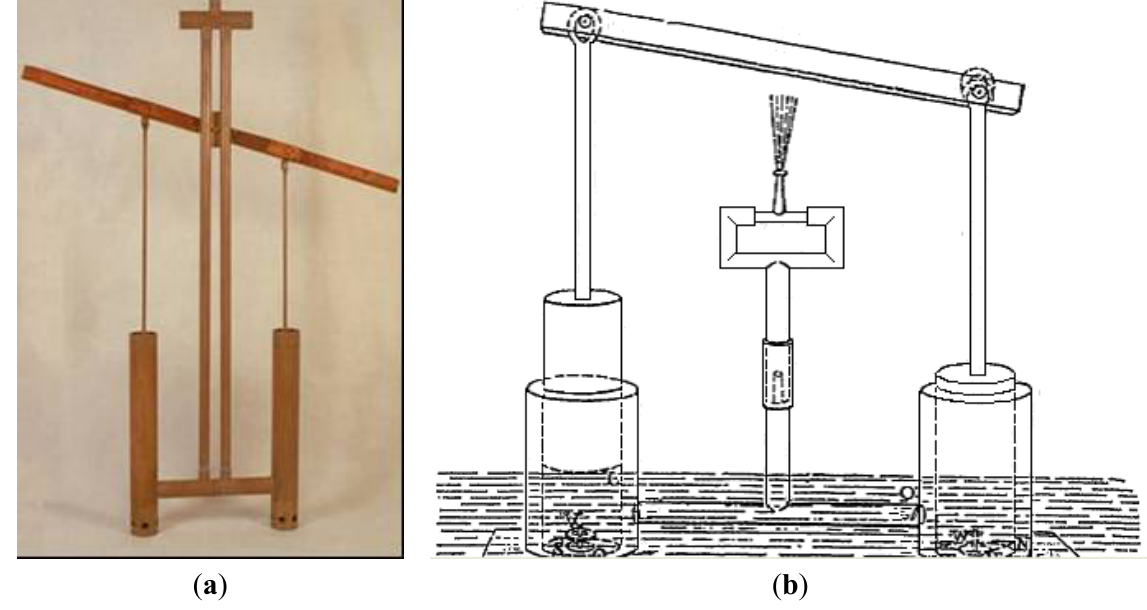
Figure 11. Ktesivius force pump as described by: ( a ) Philon; and ( b ) Heron with adjustable nozzle (adapted from [52] and [53]